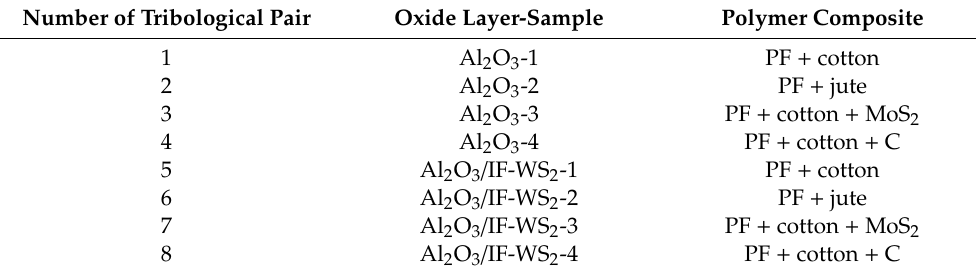
Table 1. Names and descriptions of studied